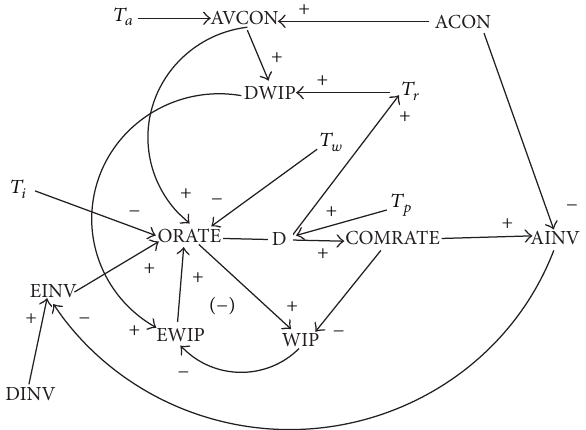
Figure 1: Casual loop of the